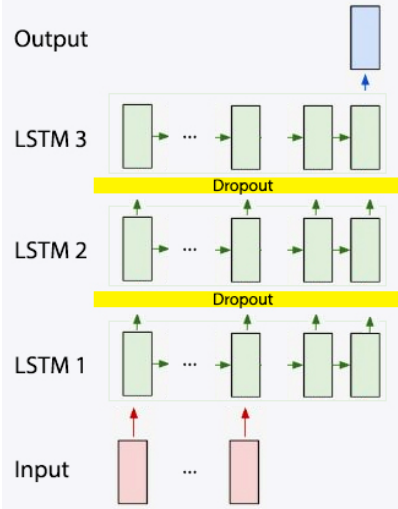
Figure 8. LSTM architecture.